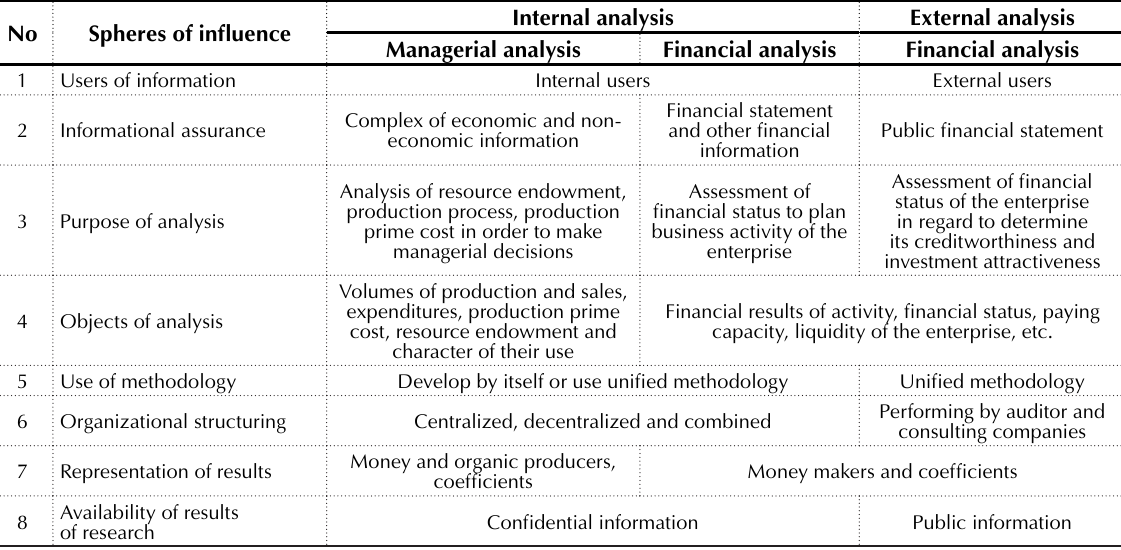
Table 1. Comparative characteristic of types of economic analysis